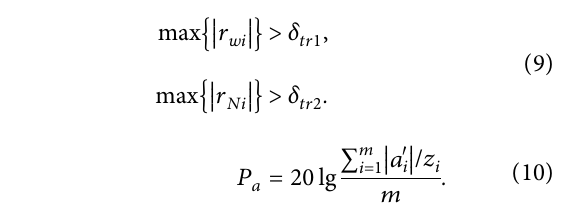
Figure 1: The schematic diagram of FDIA acting on the new energy calculation expression of the attack strength P a (unit is dB) adopted by the author is shown in formula (10).